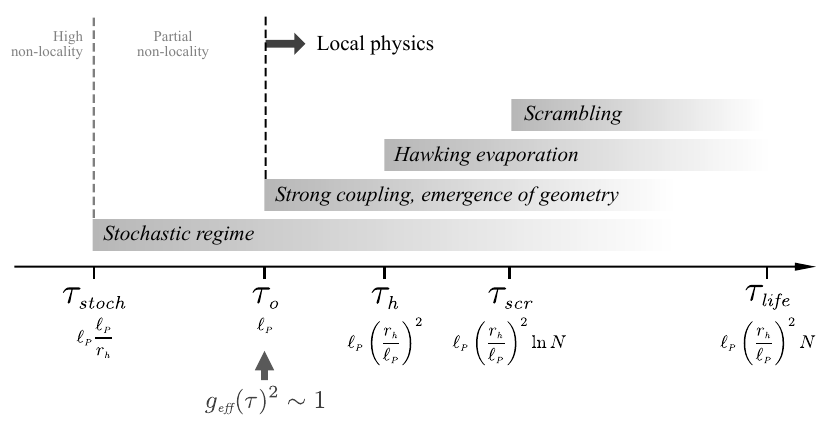
Figure 3 . The hierarchy of timescales for event horizon dynamics. Timescales t < t with non-local physics within D0 brane clusters, but timescales t > t for coarser inter-cluster